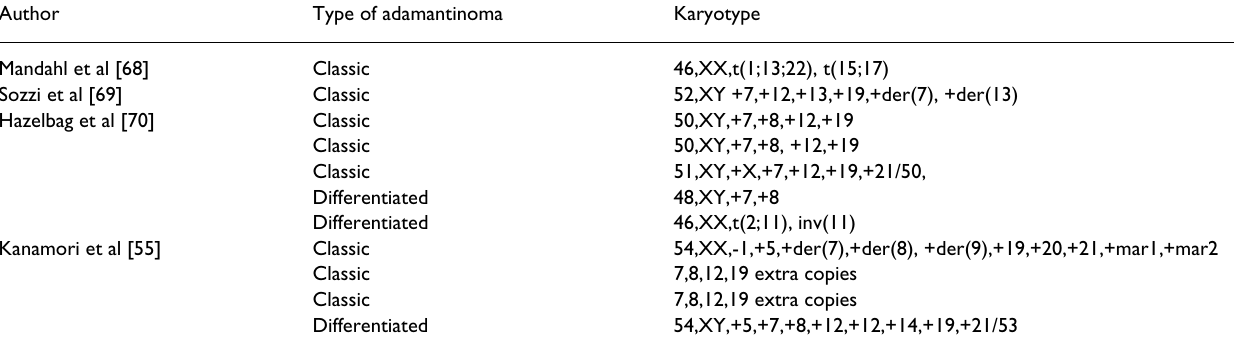
Table 4: Cytogenetic findings in